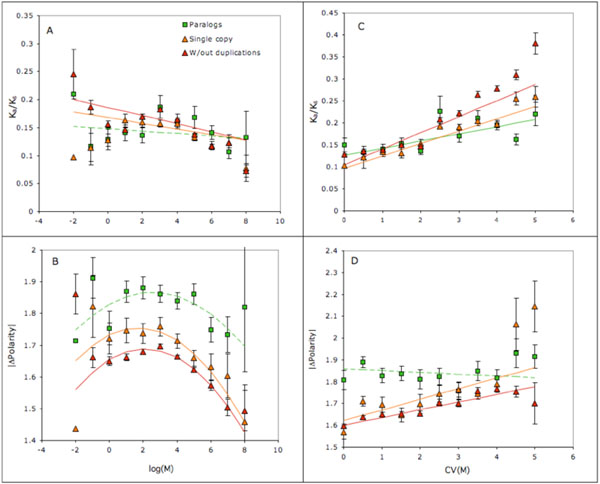
Rates and radicality of amino acid substitution vs. expression level and ubiquity. Relationship between relative substitution rate (Ka/Ka; A, C) and mean absolute change of polarity (|ΔP|; B, D) and log mean gene expression rate in whole fly (A, B) and coefficient of variation of expression rate across larval and adult tissues (C, D). Expression data from [22]. Solid lines: regressions significant at P<0.0001; dashed lines: regression without significant terms (shown for a comparison). Second-degree polynomial regression lines are shown when the quadratic term is significant, otherwise a linear regression is used.